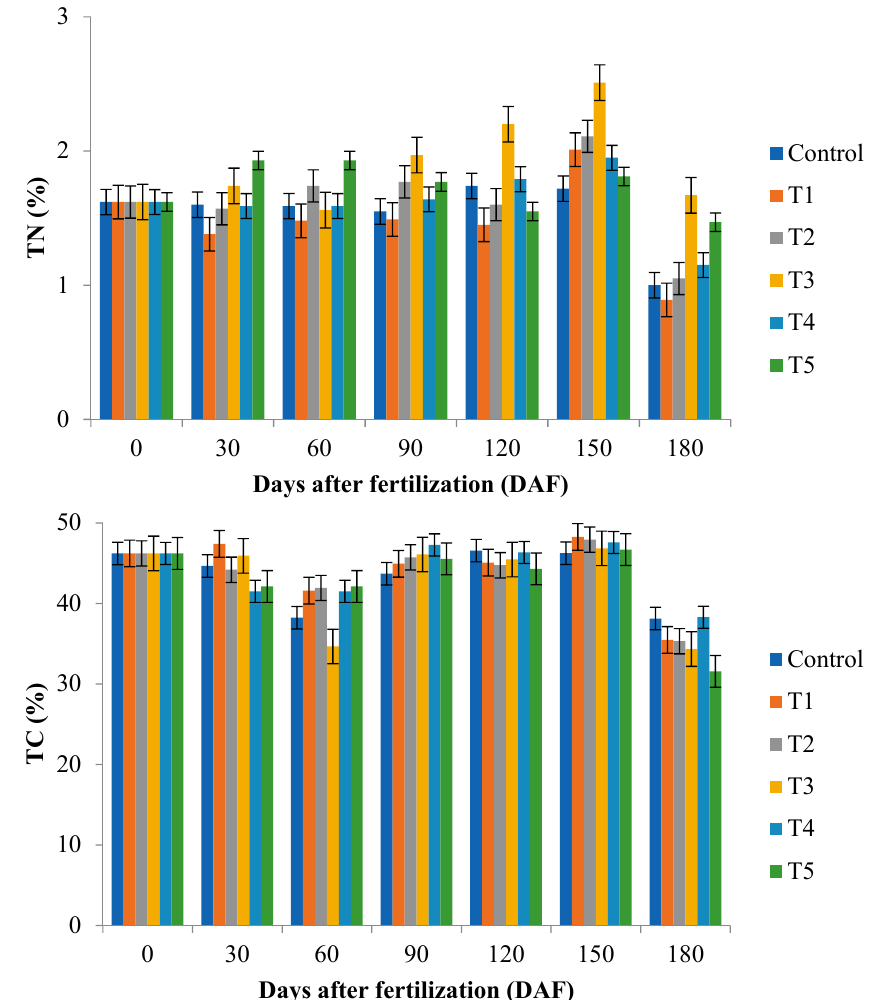
Figure 2. Total nitrogen (TN) and total carbon (TC) of leaf samples of cocoplum plants grown in different fertilization rate at 0, 30, 60, 90, 120, 150, and 180 days after fertilization. 15 g (control), 15 g (supplemented with +15 g applied 2 times in November and March; T1), 15 g (+15 g November; T2), 30 g (+15 g November and March; T3), 30 g (+15 g November; T4), and 45 g (+15 g November and March; T5).